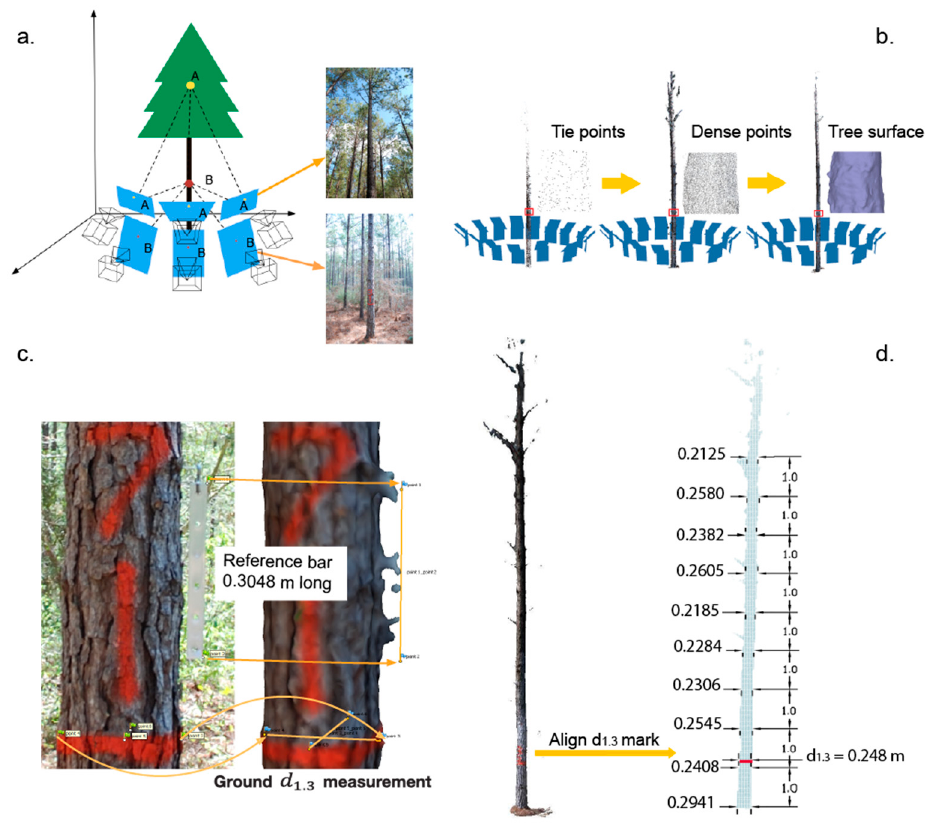
Figure 2. Workflow of the photogrammetric-based stem reconstruction and diameter measurement. ( a ) Field photographs for an individual tree; ( b ) structure from motion (SfM) process of reconstruction (tie points, densified points, surface); ( c ) scaling the photogrammetric point clouds (PPC) with reference bar and d 1.3 ; ( d ) diameter measurements in AutoCAD.